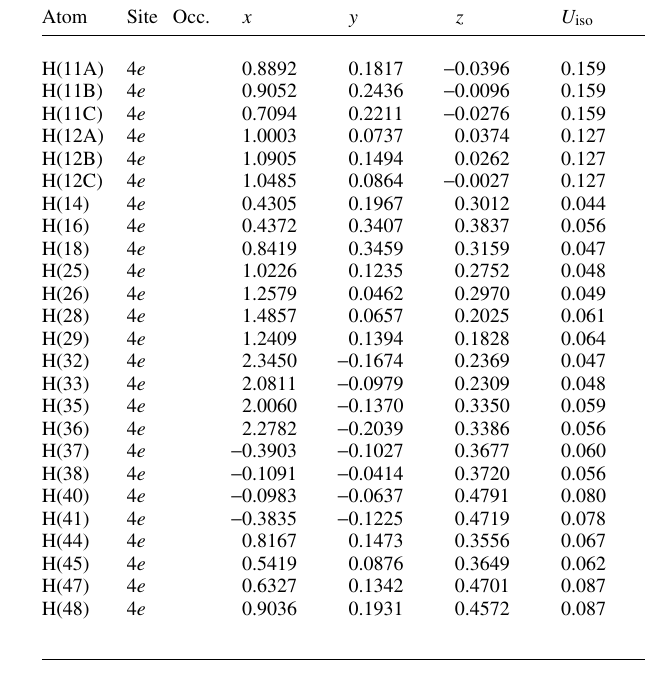
Table 2. Atomic coordinates and displacement parameters (in Å 2 ) . Atom Site